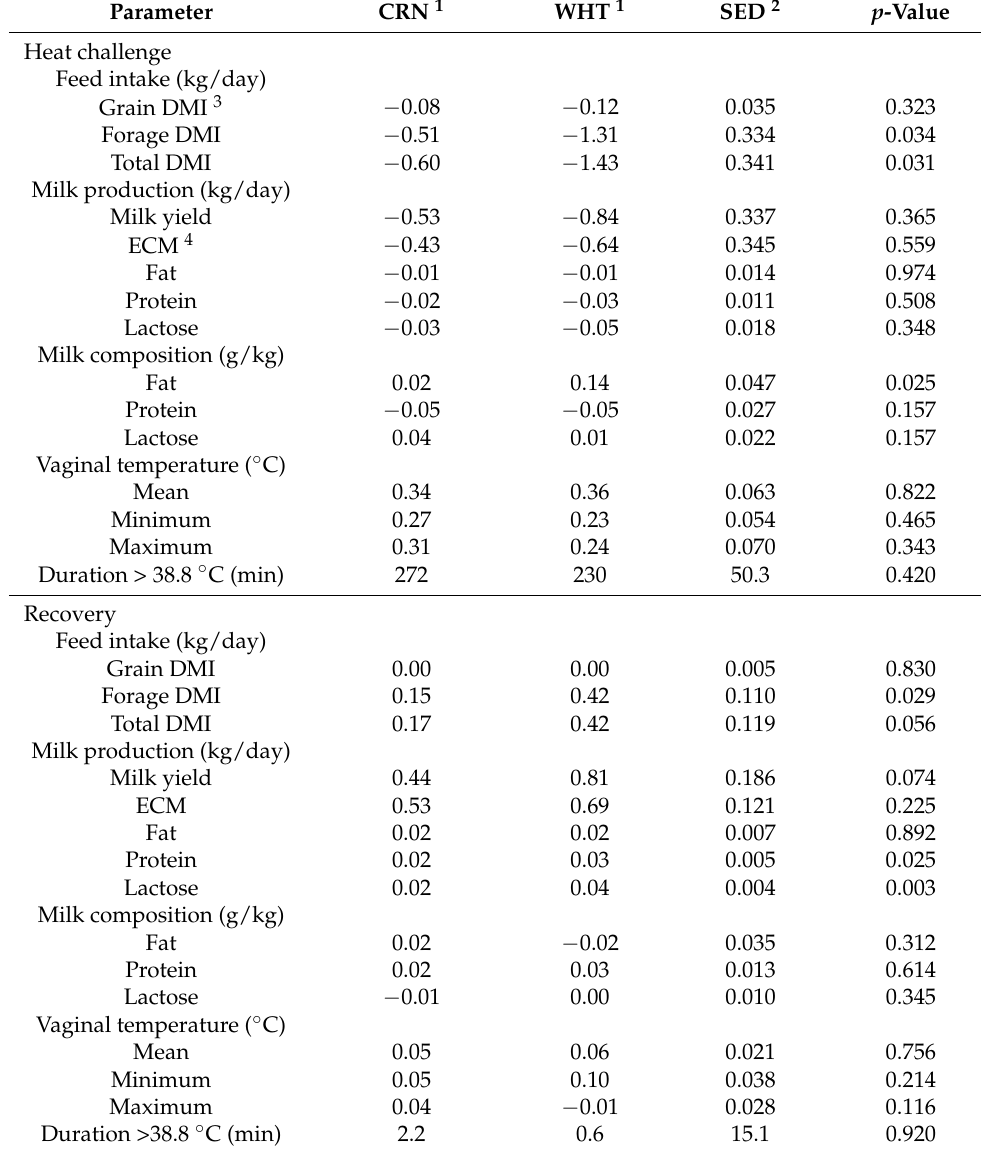
Table 6. Mean change per day (mean regression slope) within the heat challenge and recovery periods for feed intake, milk, and vaginal temperature